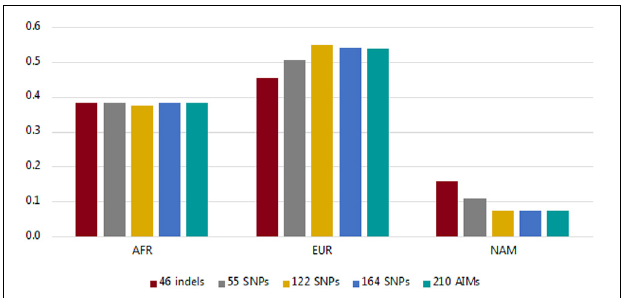
FIGURE 4 | Average ancestry proportions per component for the Rio de Janeiro sample reported by the five AIM sets considered.